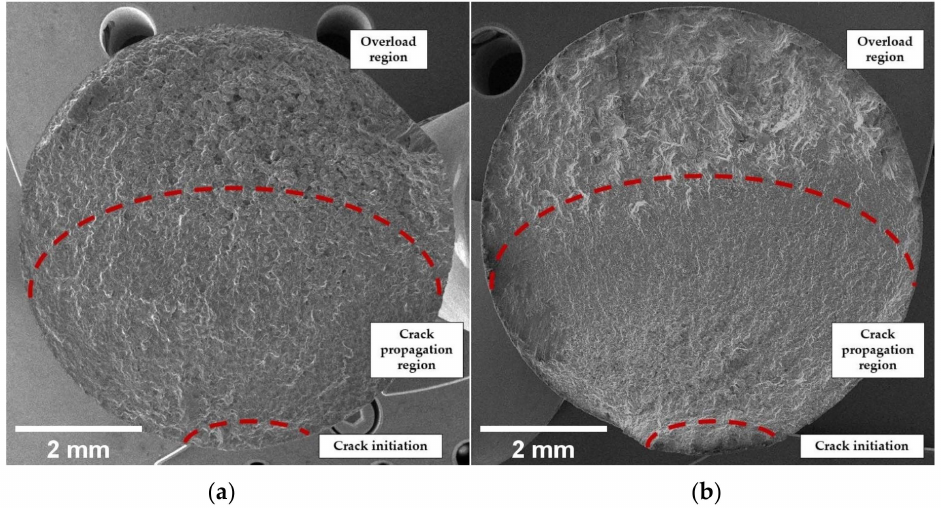
Figure 12. Fatigue tests (4-point rotating bending): SEM overview of the fracture surface of ECO- treated ( a ) and PEO-treated ( b ) samples, with distinct regions of fatigue failure.